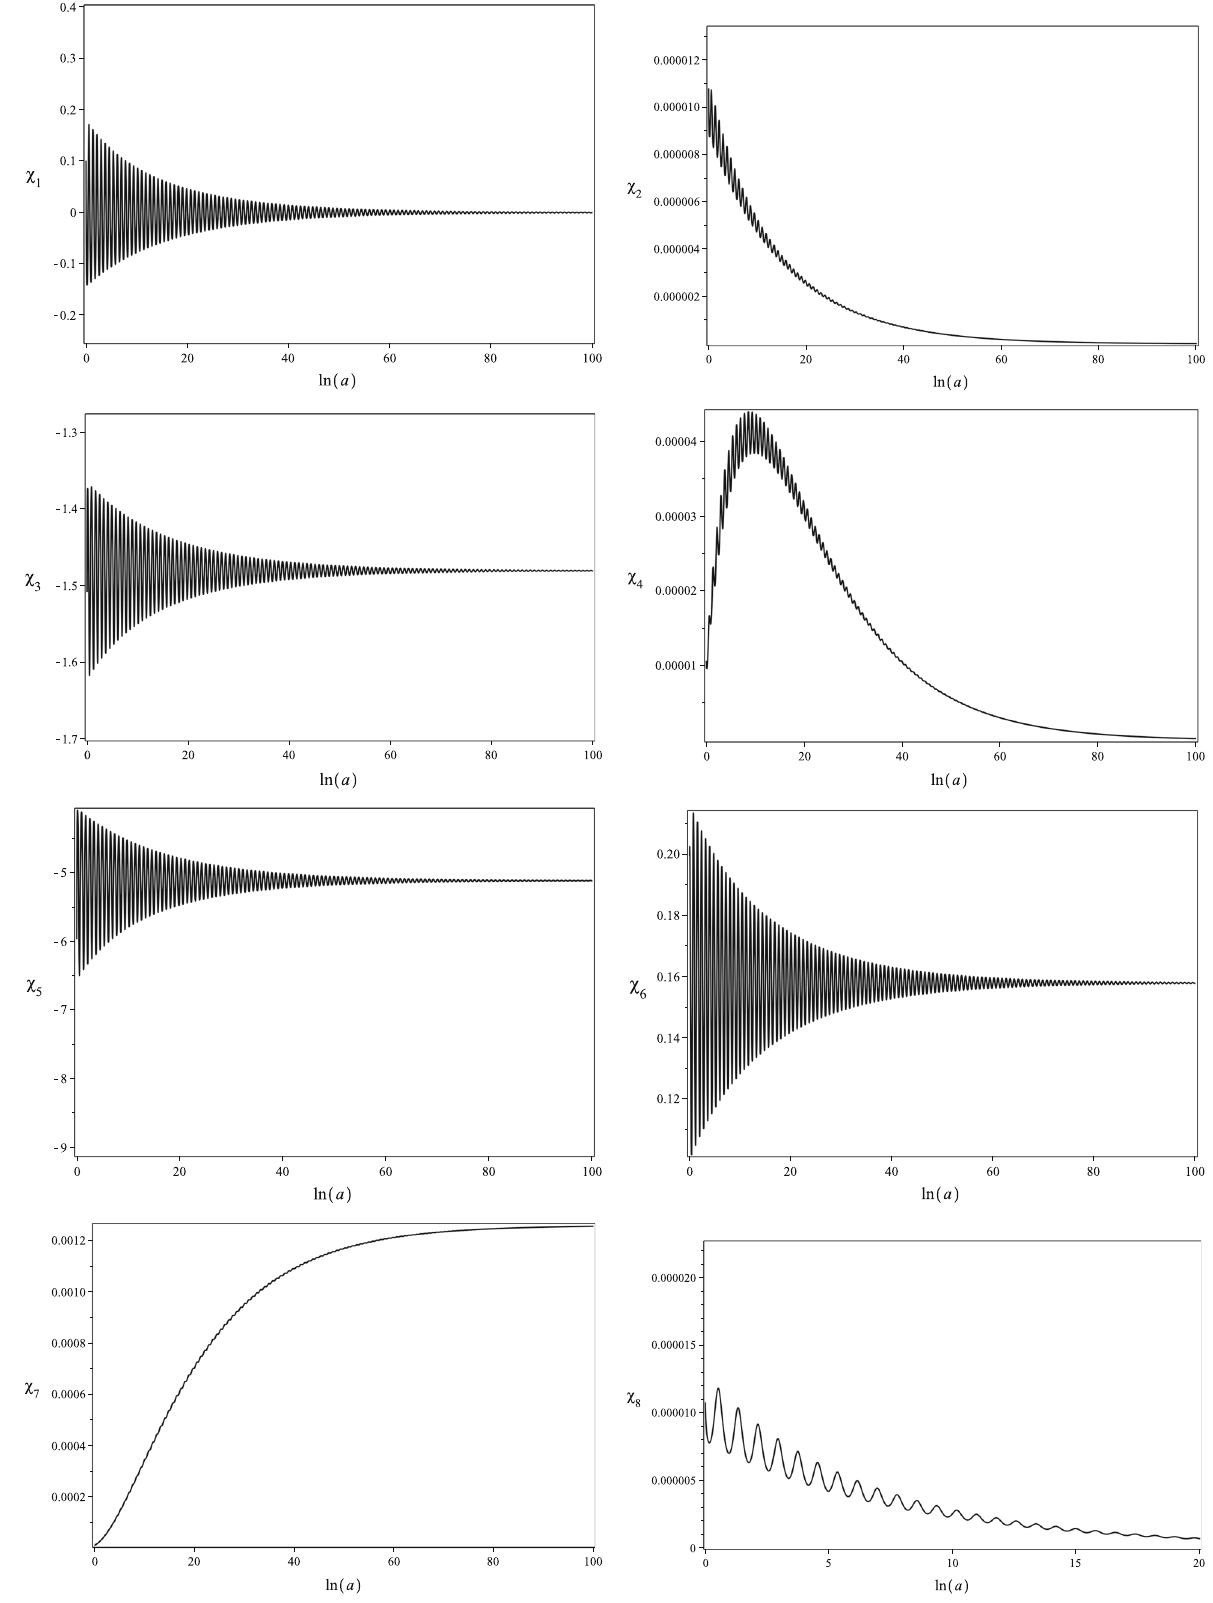
Fig. 4 Dynamical behavior of new variables for best values of α and best fitted initial